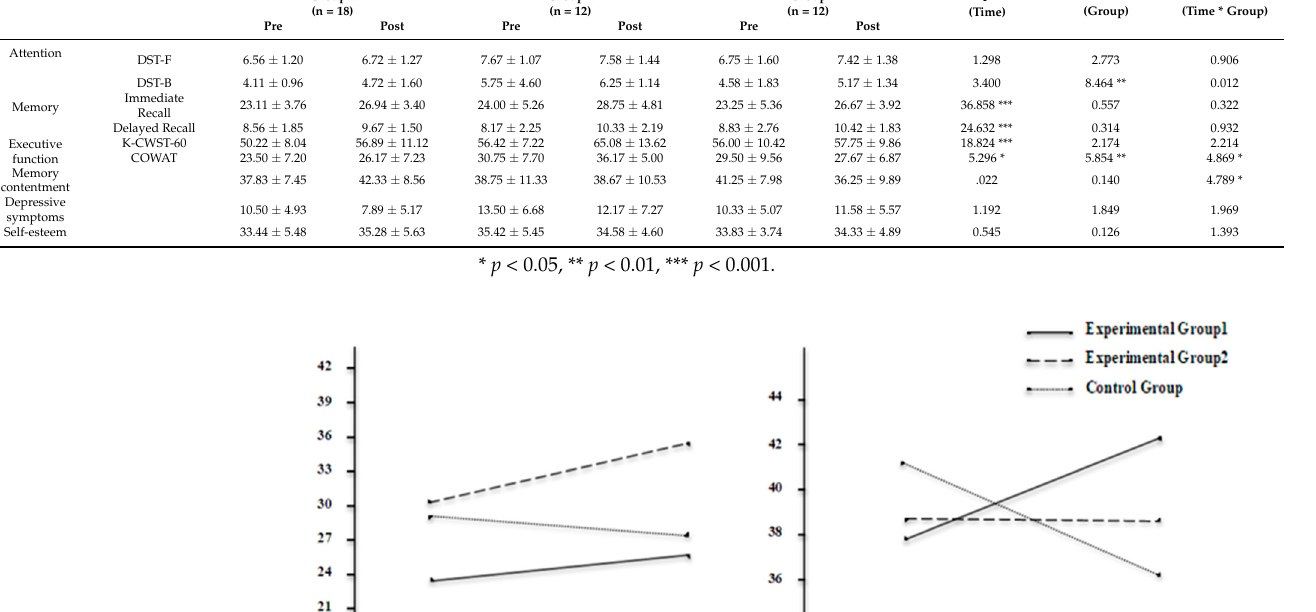
Table 3. Effects of intervention on cognitive function, depressive symptoms, and self-esteem (N = 42). Experimental Group1 (n=18)